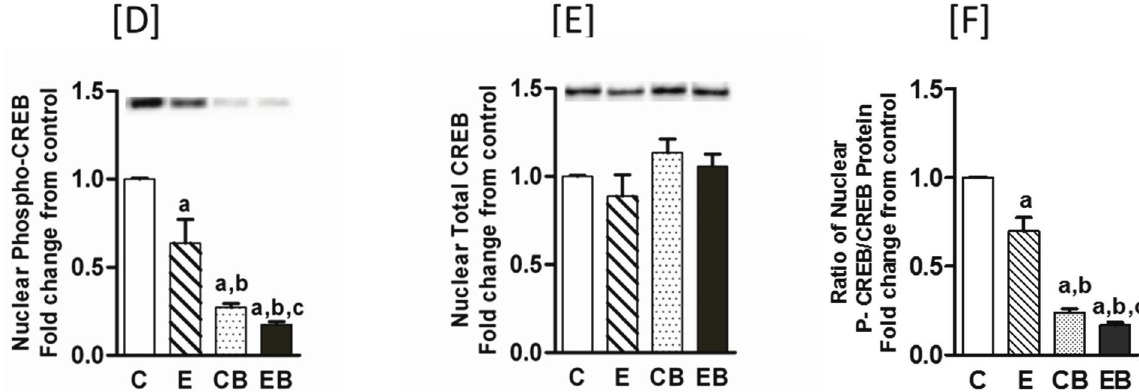
Figure 7. Phosphorylated CREB and CREB protein in hepatic extracts from chronic ethanol-binge treated mice. Changes in CREB and P-CREB were determined by western blotting of whole cells extracts (WCE, upper panel ( A – C )); and nuclear fraction (lower panel ( D – F )). Images of representative blots are also shown. The ratio of P-CREB/CREB are also shown. Values are mean ± SE ( n = 4 mice). a: significant compared to control ( p < 0.05); b: significant from chronic ethanol group ( p < 0.05); c: significant